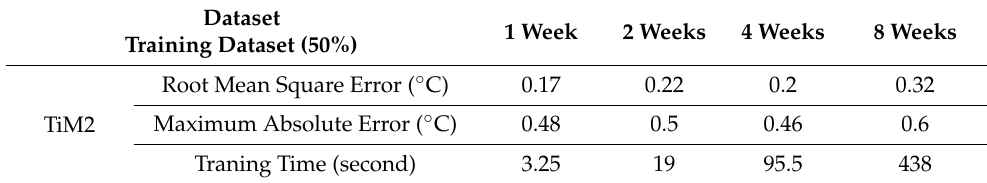
Figure 10. Estimation and observation of indoor temperature TiM2 in different dataset sizes. Table 5. Performance indices of the compensation of TiM2 data.